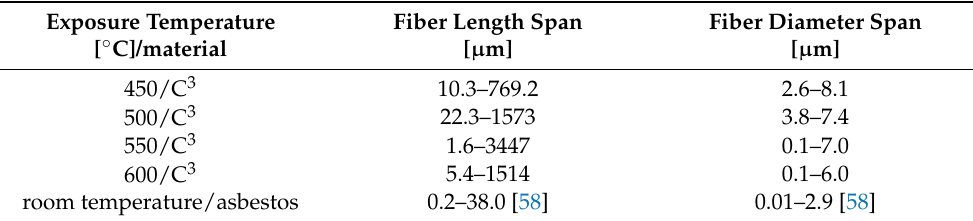
Table 4. Spans of fiber length and diameters in abrasive PM 10 formed during dry-cutting of thermally stressed C 3 (450, 500, 550, and 600 ◦ C, air atmosphere, 3 h) in comparison to asbestos